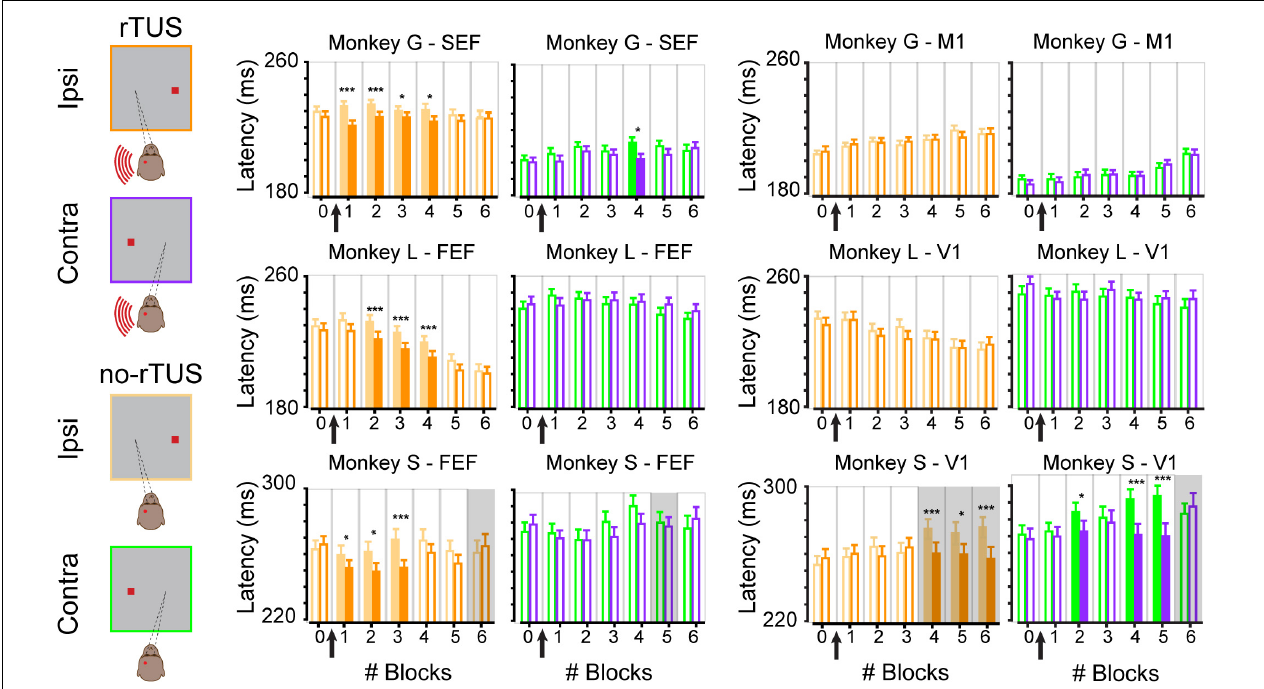
FIGURE 3 | Time course of rTUS effect on mean latencies. Mean latencies per block when rTUS was directed toward the oculomotor areas (SEF/FEF; two left columns) or the control areas (M1/V1; two right columns) in three animals (monkey G; top row, monkey L; middle row and monkey S; bottom row). Each bar represents the mean latency averaged over all successful antisaccades in each block of trials for each side (contra/ipsi), error bars indicate SEM. Open bars indicate non-significant differences (Wilcoxon rank sum test, p > 0.05); filled bars indicate significant differences (* for p < 0.05 and *** for p < 0.001, corrected for multiple comparisons). Gray backgrounds indicate when error rates were superior to 15% although light backgrounds indicate when error rates were inferior to 15%. Black arrows schematize when rTUS was performed between blocks #0 and